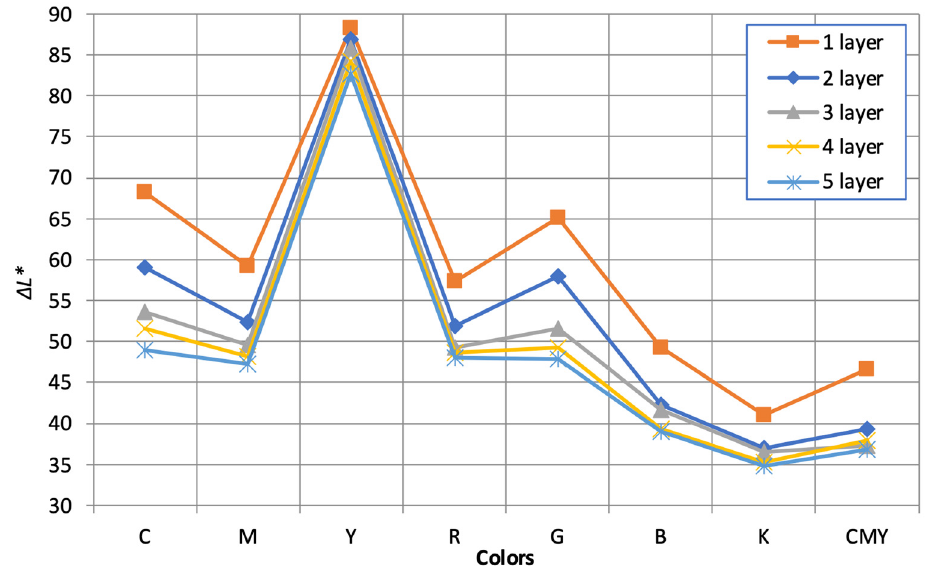
Figure 8. Different colors changes of Δ L * value depending on ink layer when printing in 4 passes.